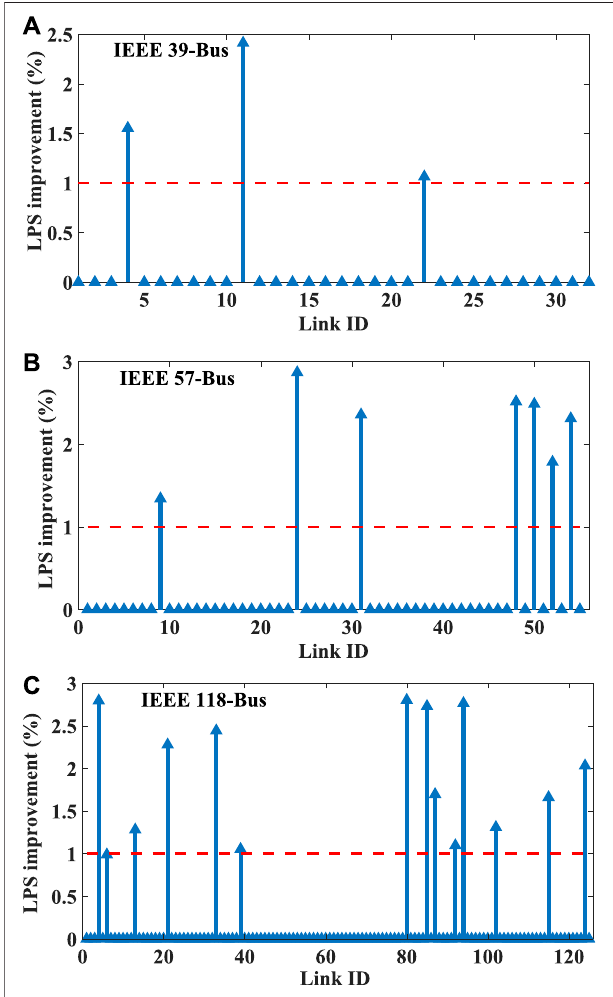
FIGURE 3 | LPS improvement by increasing 1% capacity of each transmission link in (A) IEEE 39-Bus Case, (B) IEEE 57-Bus Case, and (C) IEEE 118-Bus